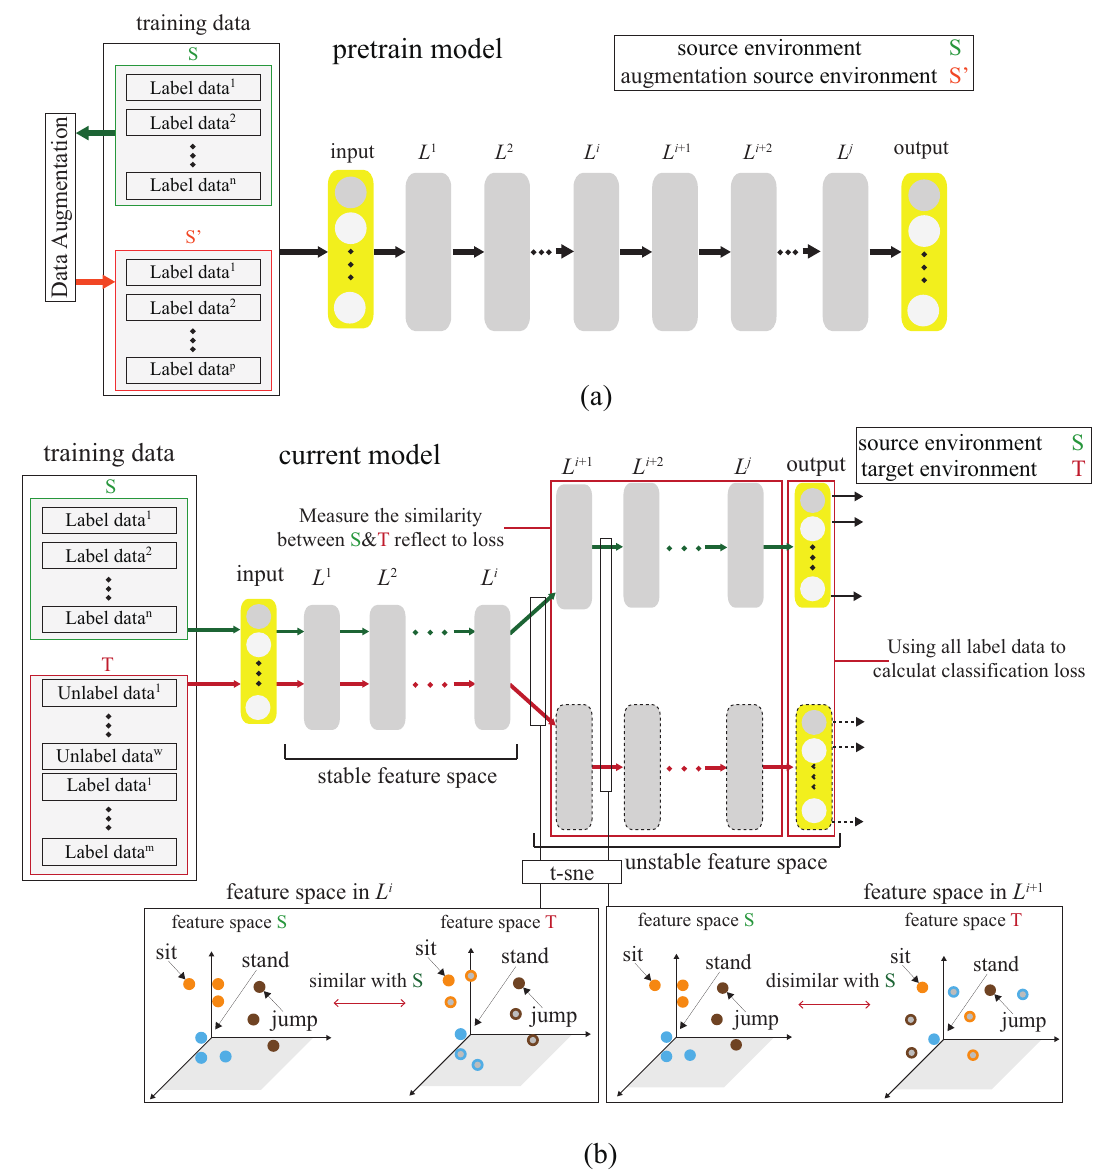
Figure 4. Basic idea of DA-DADA scheme. ( a ) The pre-trained process. ( b ) The fine-tuning process.